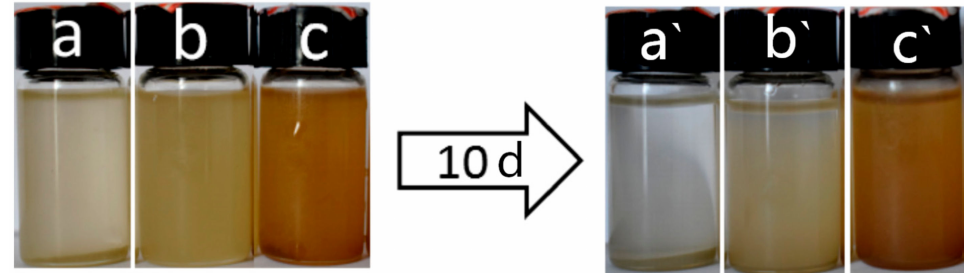
Figure 5. Digital photographs of the sedimentation of ( a ) raw mica, ( b ) mica ground at room temperature, and ( c ) mica ground at 200 ◦ C.